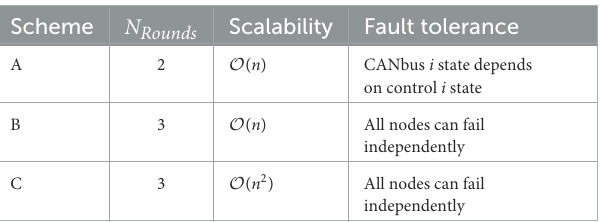
TABLE 2 CANbus replication FIT